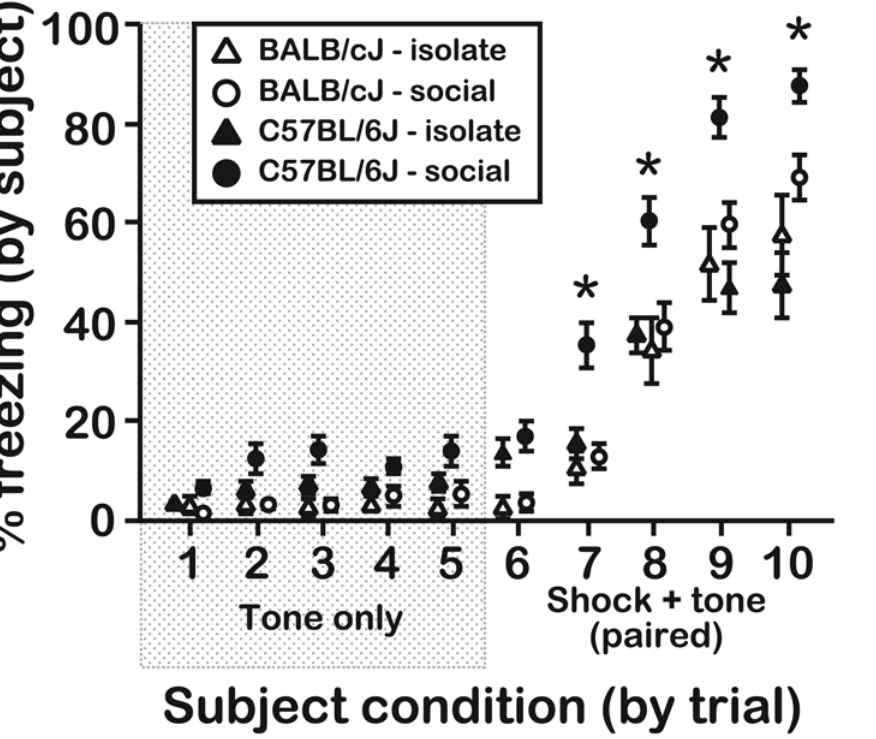
Figure 11. Freezing responses of socially and isolate-housed subjects pre-exposed to objects receiving the CS-UCS contingency. Subjects were either isolated or remained in a social housing context outside of their observations of objects receiving the paired CS-UCS during the pre-exposure session. Since freezing responses of socially housed subjects in this experiment (N=10 subjects/genotype; age=6–8 wks) did not differ (P=0.20) from responses of mice that were evaluated in the experiment presented in Figure 3a, the data were pooled for graphical presentation and statistical analysis. Social isolation did not alter the freezing responses of BALB subjects, but it depressed fear acquisition to presentation of the paired CS-UCS in B6 subjects (N=20 subjects/genotype; age=7–8 wks). Socially housed B6 subjects expressed longer freezing responses than all other groups on trials 7-10 (P=0.006). Asterisks represent significant differences between socially housed B6 subjects and all other groups as assessed by a Bonferroni step-down procedure on a trial-by-trial basis ( / =0.013 for trials 7-10). All data were scored in duplicate by 2 independent raters and are presented as the mean 6 s.e.m. Inter-rater reliability (not including pooled data from Fig. 3a), r p =0.94, d.f.=547.